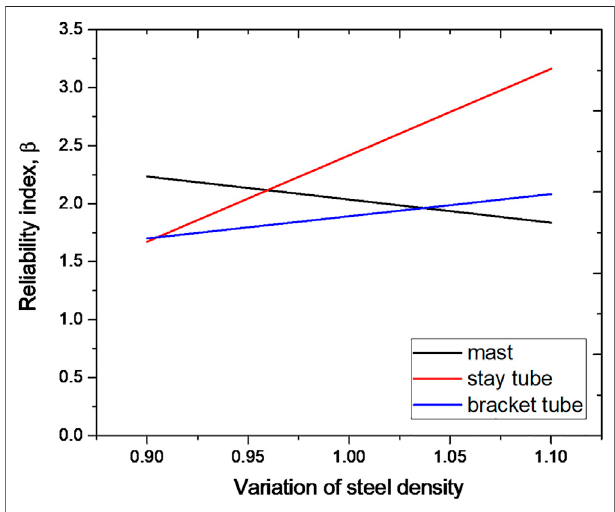
FIGURE 8 | Effect of density on reliability